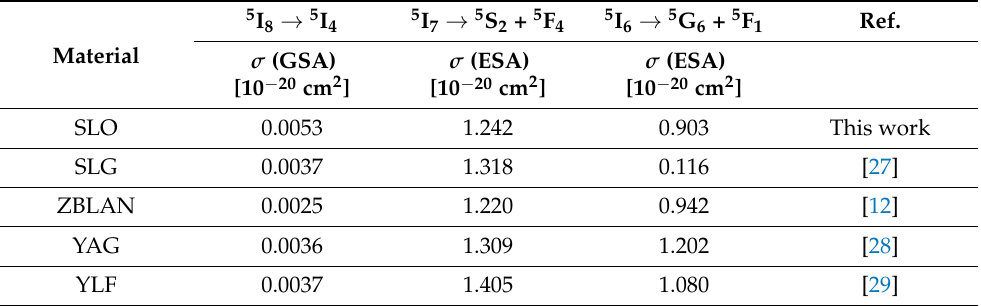
Table 5. Calculated GSA and ESA absorption cross section values for transitions involved in the 750 nm excitation process for SrLaGaO 4 and several other Ho 3+ activated materials.